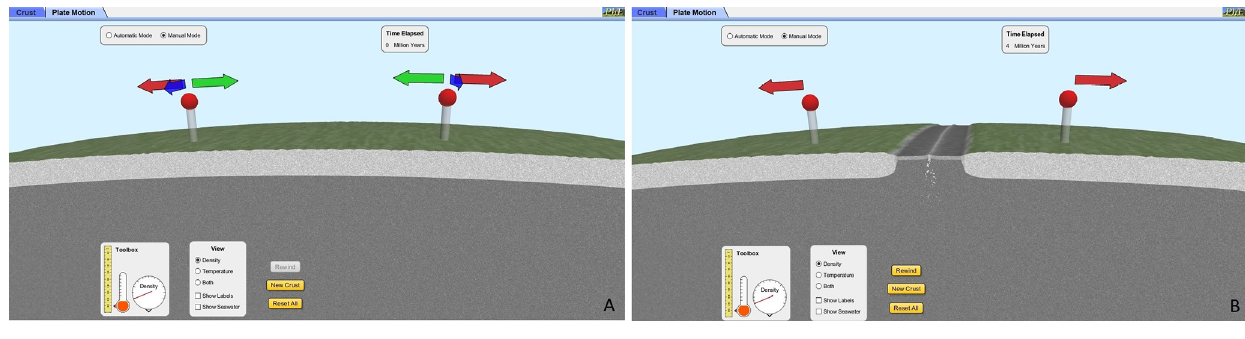
Figure 8. First tectonic situation provided to PSTs (a) and the formation of oceanic crust due to divergent movements (red arrows; b ). Caption from PhET™ Plate